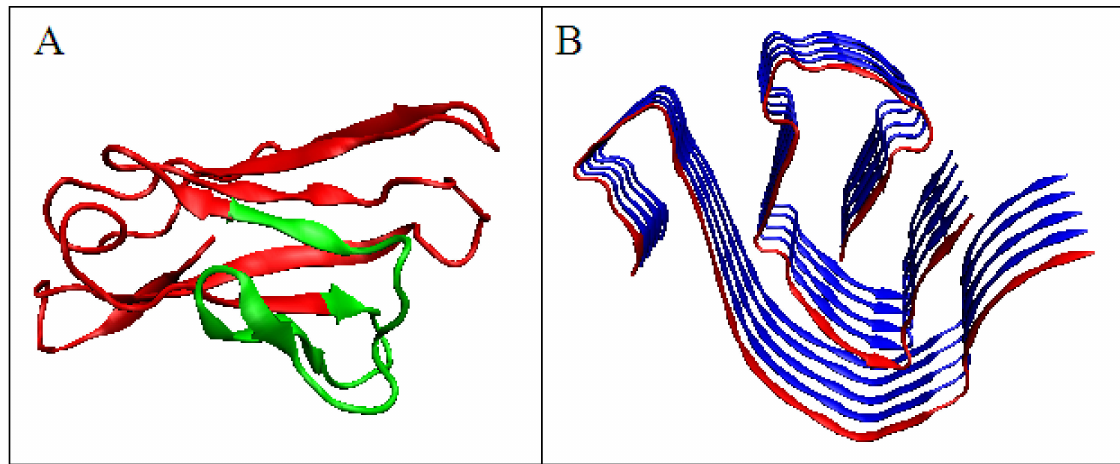
Figure 6. Domain V light chain of IgG. ( A )—Native form, the red fragment present in amyloid form. ( B )—Amyloid form, the red chain presents the form of the red fragment in